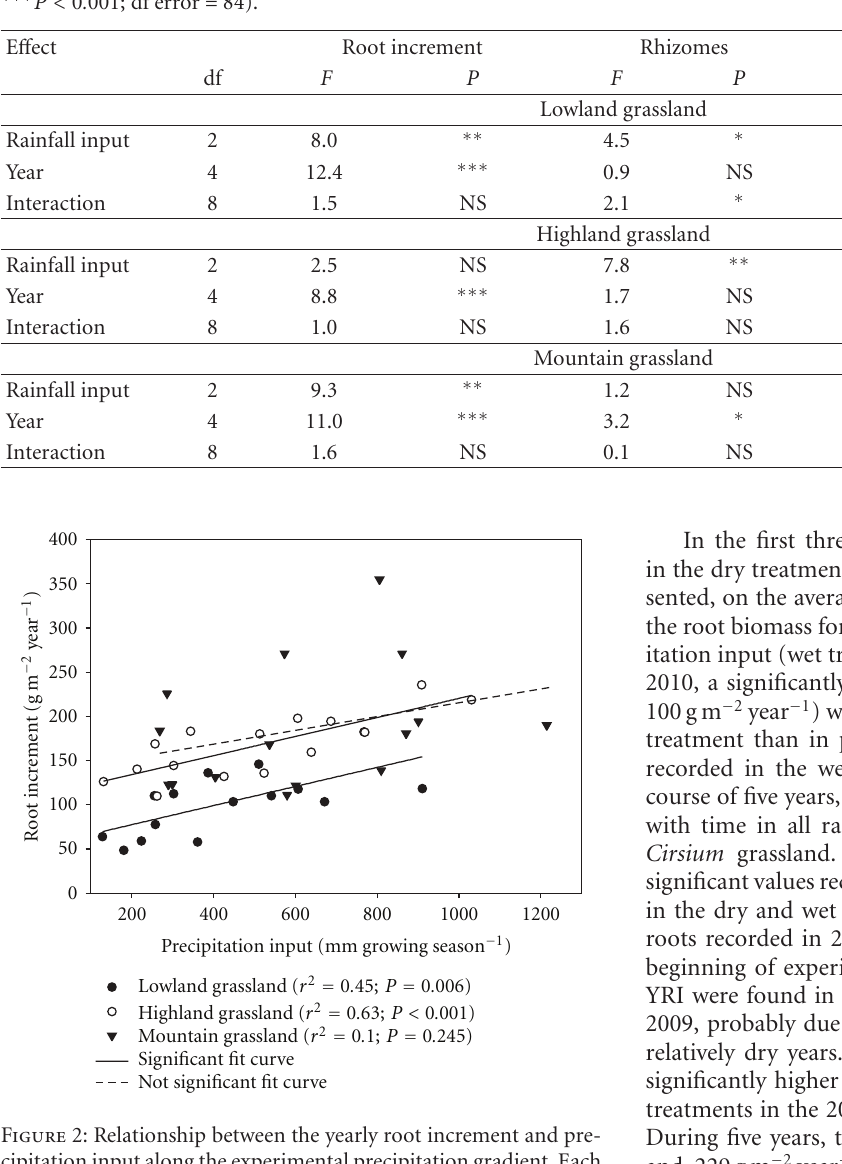
Table 3: The e ff ect of rainfall input and year on the root increment, roots, rhizomes, and total below-ground biomass (TBB): results of repeated measures analysis of variance (ANOVA), using years as repeated measures factor (NS: not significant, ∗ P < 0 . 05, ∗∗ P < 0 . 01, ∗∗∗ P < 0 . 001; df error = 84).